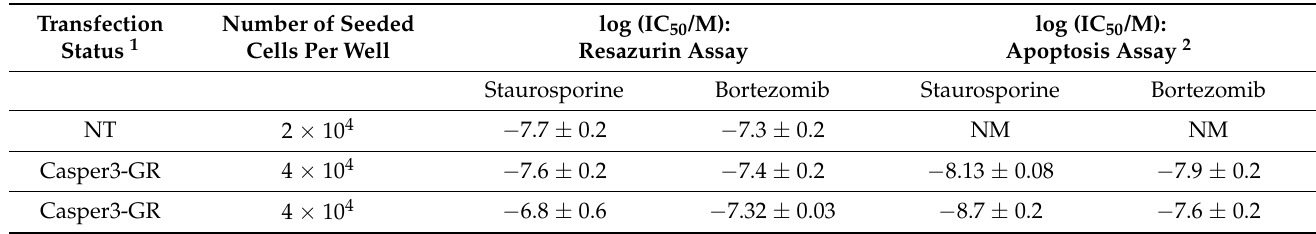
Table 1. Comparison of logarithms of IC 50 values ± SEM measured for staurosporine or bortezomib in the HeLa cell line using different assay formats (N = 3 for each type of